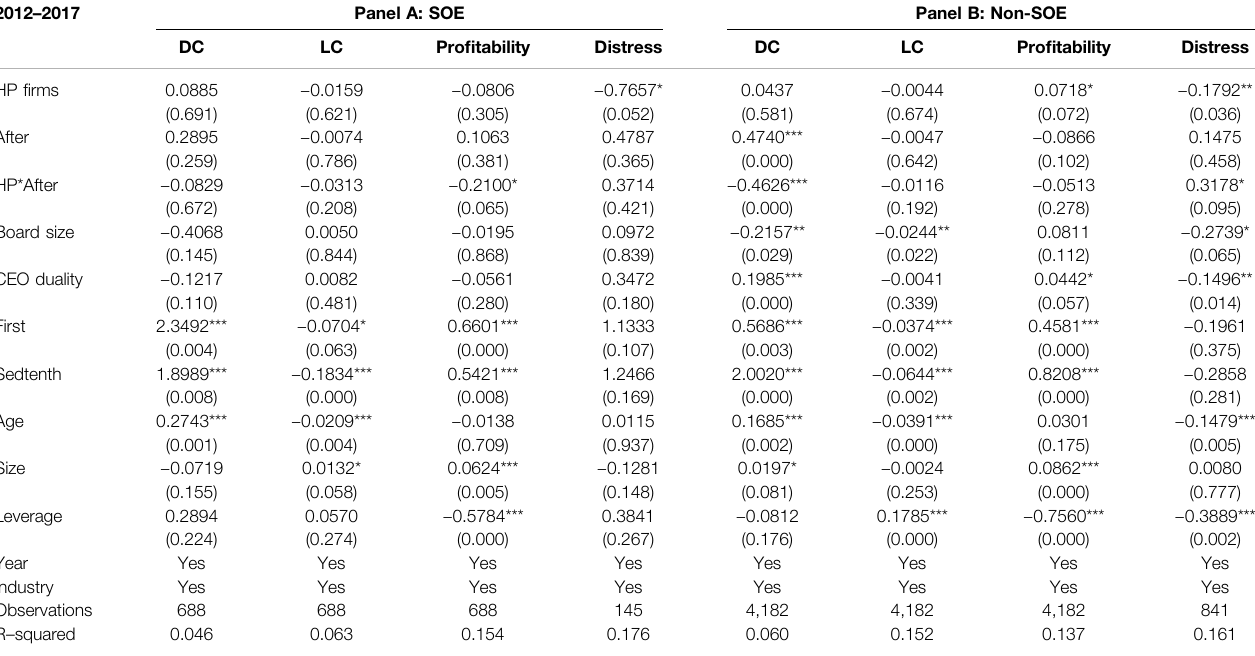
TABLE 11 | Subsample tests-SOEs and non-SOEs. This table presents the results of sub-sample tests: SOEs and non-SOEs. For the sample period of 2001 – 2006, we fi nd that the environmental protection fee has insigni fi cant in fl uence on fi rm performance for various sub-samples. In this case, we only report the results of the sample period of 2012 – 2017 in this section for brevity purpose. For the probit regression (column Distress), we report the marginal effect rather than the coef fi cients. For the de fi nitions of variables refer to Appendix A . P -values are in